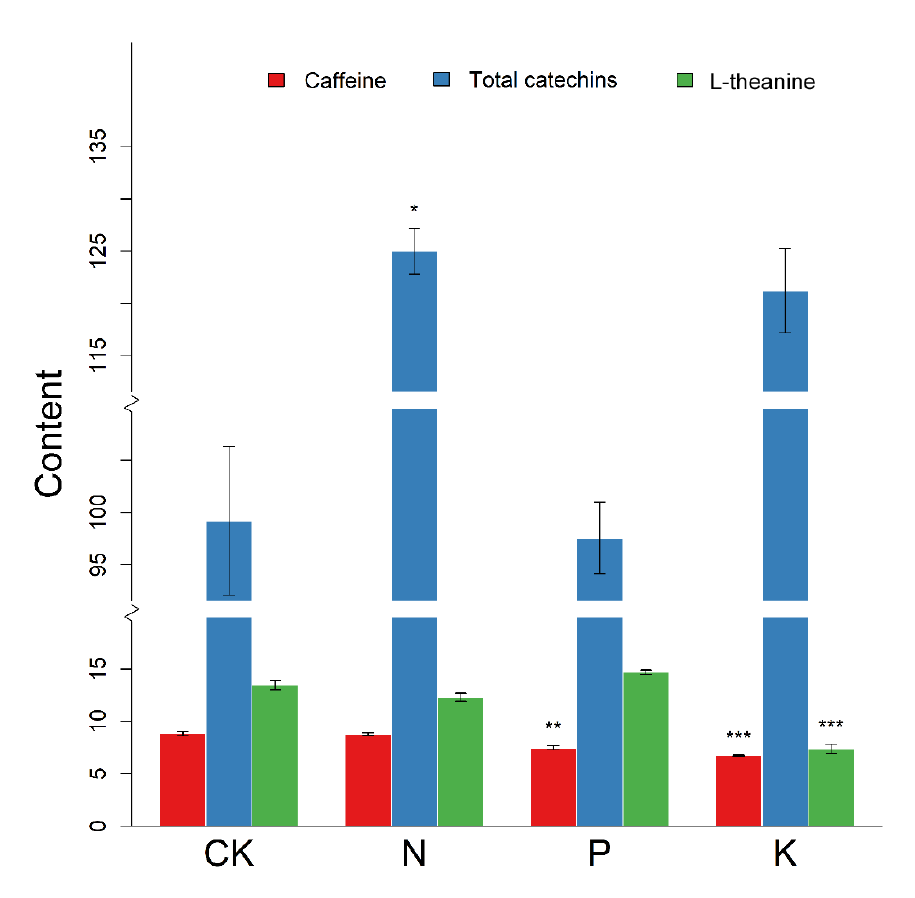
Figure 6. The content (mg/g) of total catechins, L -theanine, and caffeine under N, P, and K starvation. Total catechins is the sum of all individual catechin isomers, that is: Catechin(C), catechin gallate (CG), epicatechin (EC), epicatechin gallate (ECG), epigallocatechin (EGC), epigallocatechin gallate (EGCG), gallocatechin gallate (GCG), and gallocatechin (GC). Asterisks indicate the level of significance compared with the control group (CK) treated with the full nutrient solution. The error bars show the SE. Significance level is represented as stars: *, **, *** refer to p -values: 0.05, 0.01, and 0.001, respectively.